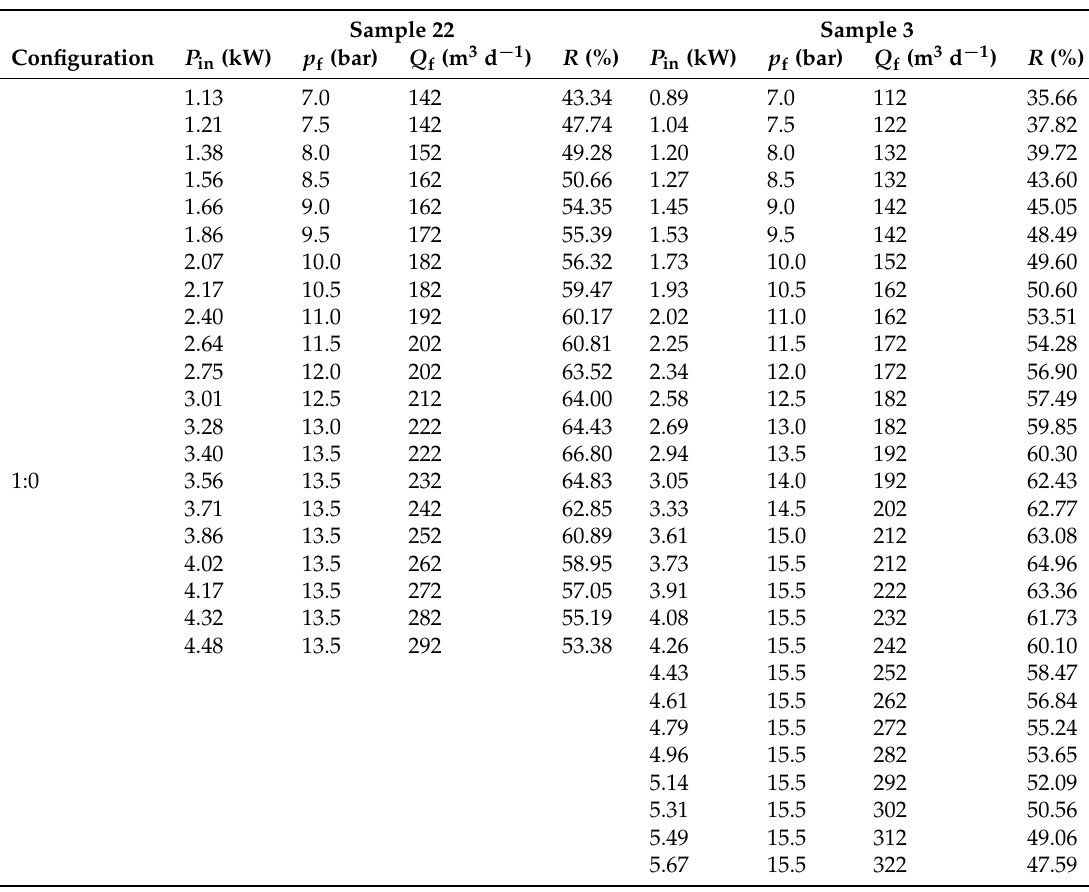
Table A2. P in , p f , Q f and R for maximizing Q p considering three different BWRO configurations and using samples 22 and 3 (Table 1) as